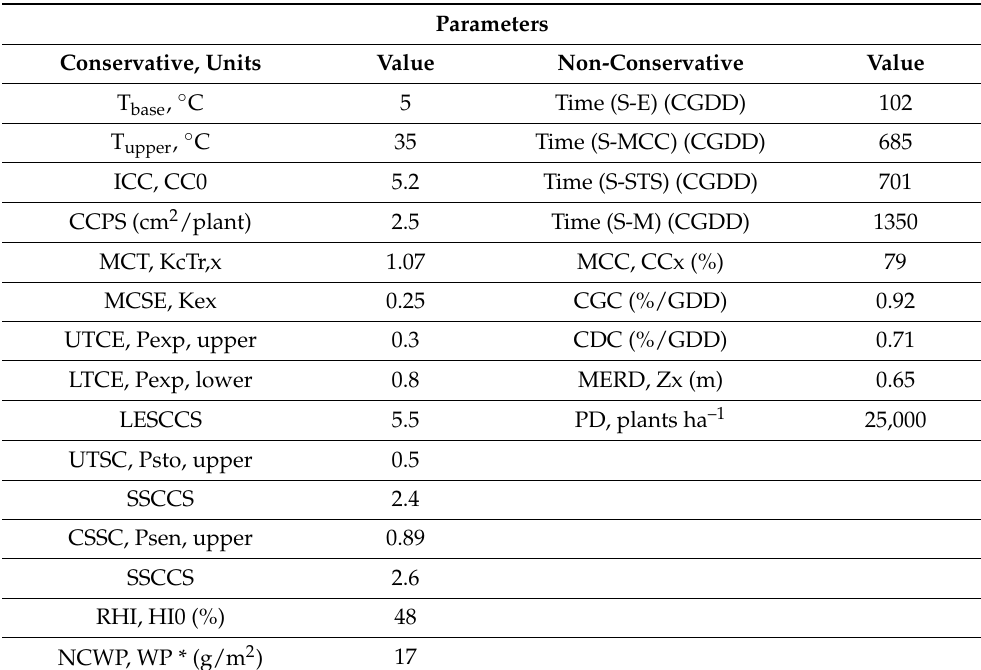
Table 2. Main input parameters used for the calibration (2019/2020 growing season) and the valida- tion (2020/2021 growing season) for the Sakha 95 variety.